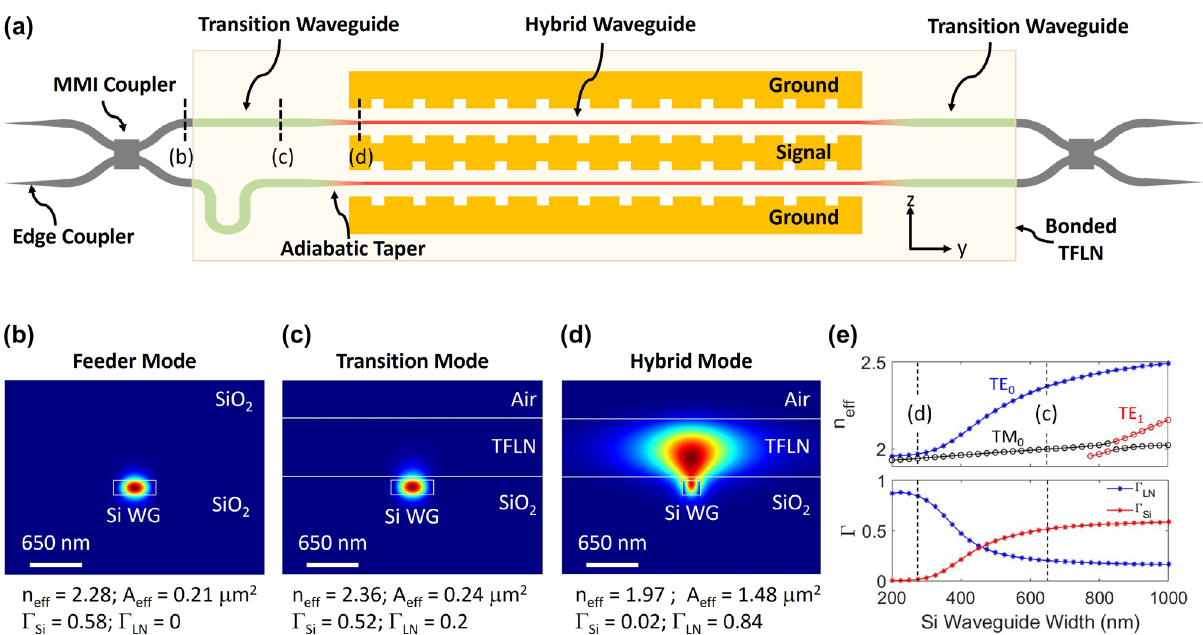
Figure 1. ( a ) Top-view schematic (not to scale) of the Si/LN MZM. The transition region consists of the transition waveguide and adiabatic tapers (shown in green), and the phase shifter section consists of the hybrid waveguide (shown in red). Cross-sectional simulated Poynting vector of the ( b ) feeder Si waveguide (no LN film), ( c ) transition Si waveguide, and ( d ) hybrid Si/LN waveguide. ( e ) The simulated effective index of the first three Si/LN modes (top), and the confinement factor in the TFLN layer and Si waveguide (bottom) as a function of Si waveguide width at (cid:31) = 1550 nm. The dashed lines indicate the modes shown in panels ( c ) and ( d